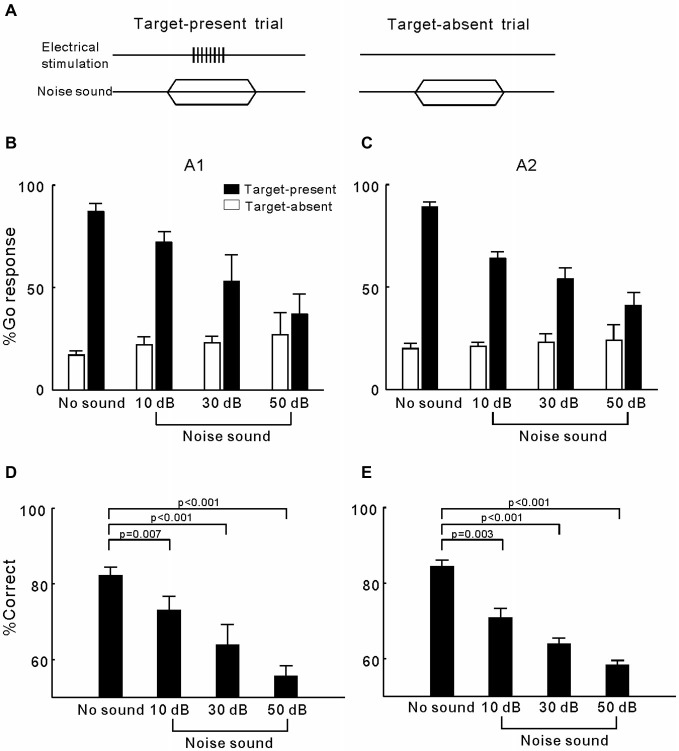
Detection of ICMS presented together with wideband noise. (A) Presenting both ICMS and noise in a target-present trial but only noise in a target-absent trial. (B) Percentage of Go responses in each Go/No-Go task for detection of ICMS in A1. Open and filled bars represent the mean percentage of Go responses in the target-absent and target-present trials, respectively. Error bars represent SE. (C) Percentage of Go responses in each Go/No-Go task for detection of ICMS in A2. (D) Mean and SE for the percentage of correct ICMS detection in A1 when presented together with different levels of noise. P values were obtained using ANOVA with a post hoc Student’s t-test. (E) Mean and SE for the percentage of correct ICMS detection in A2.